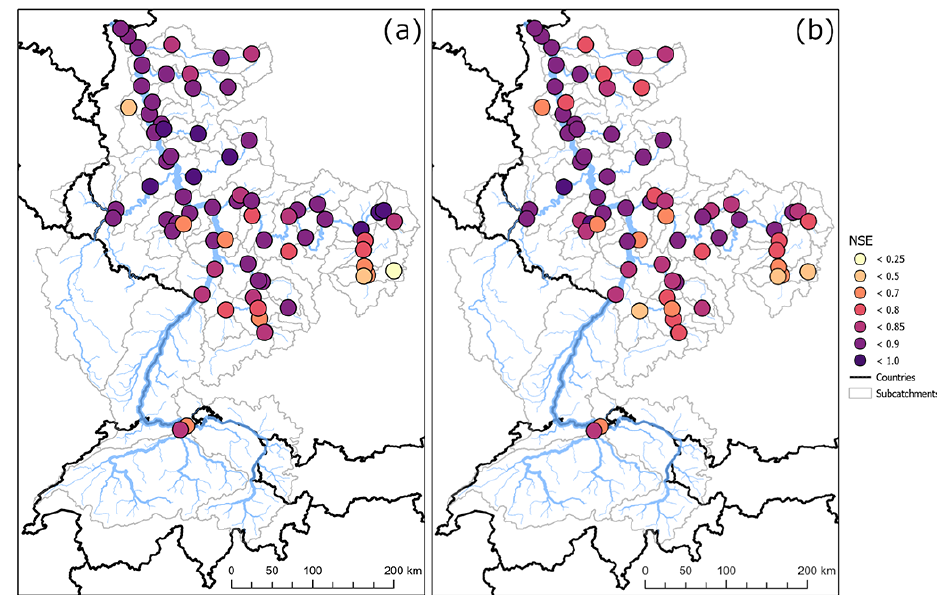
Figure 5. Nash–Sutcliffe model efficiency coefficient (NSE) for the 71 catchments of the Rhine basin (validation period 1986–2009) with (a) HYRAS and (b) E-OBS as HM forcing. Higher values indicate better